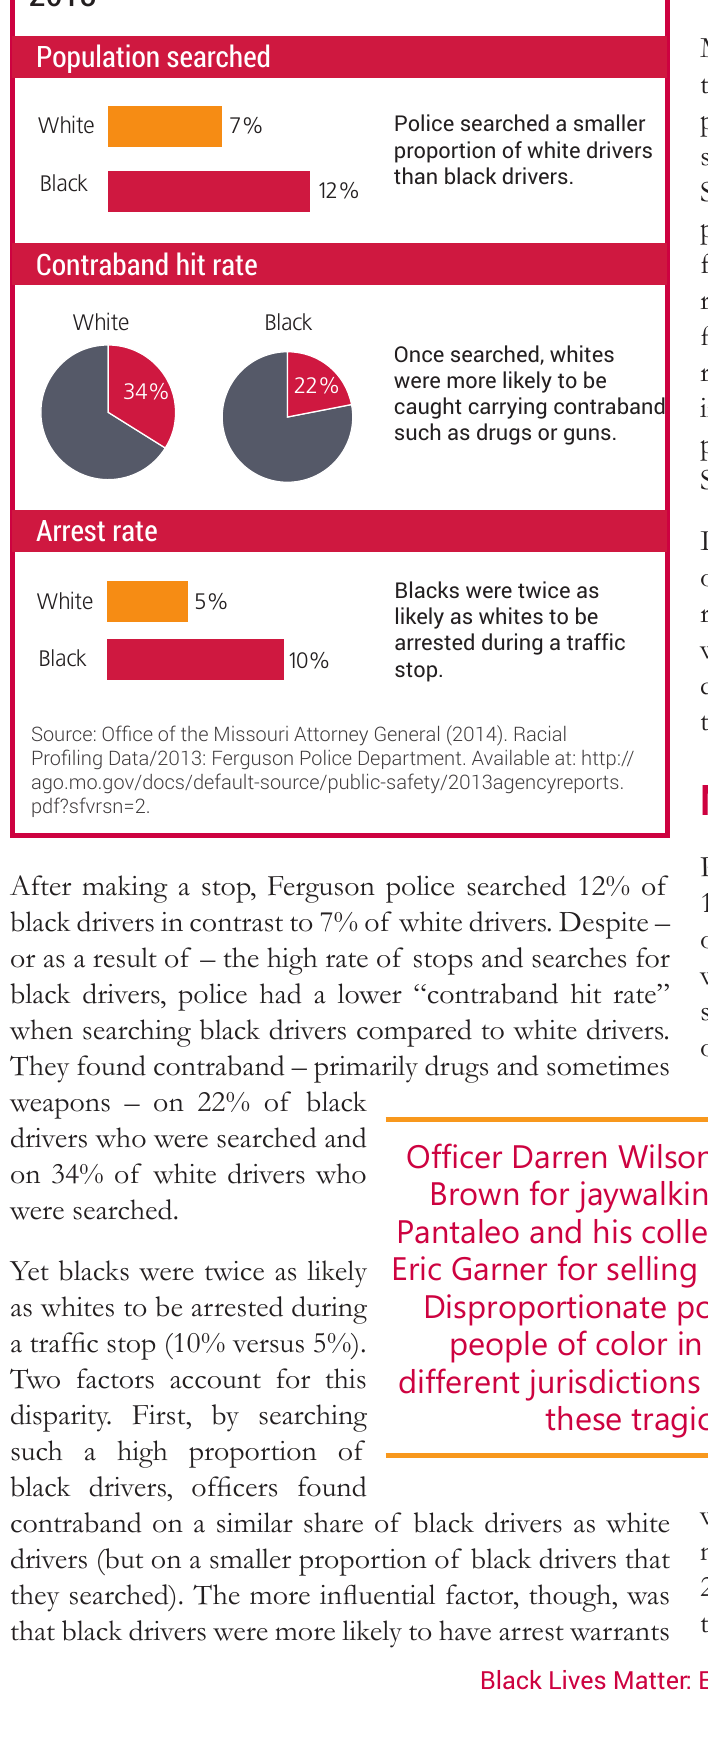
Figure 2. Ferguson traffic stops: Population searched, contraband hit rate, and arrest rate,